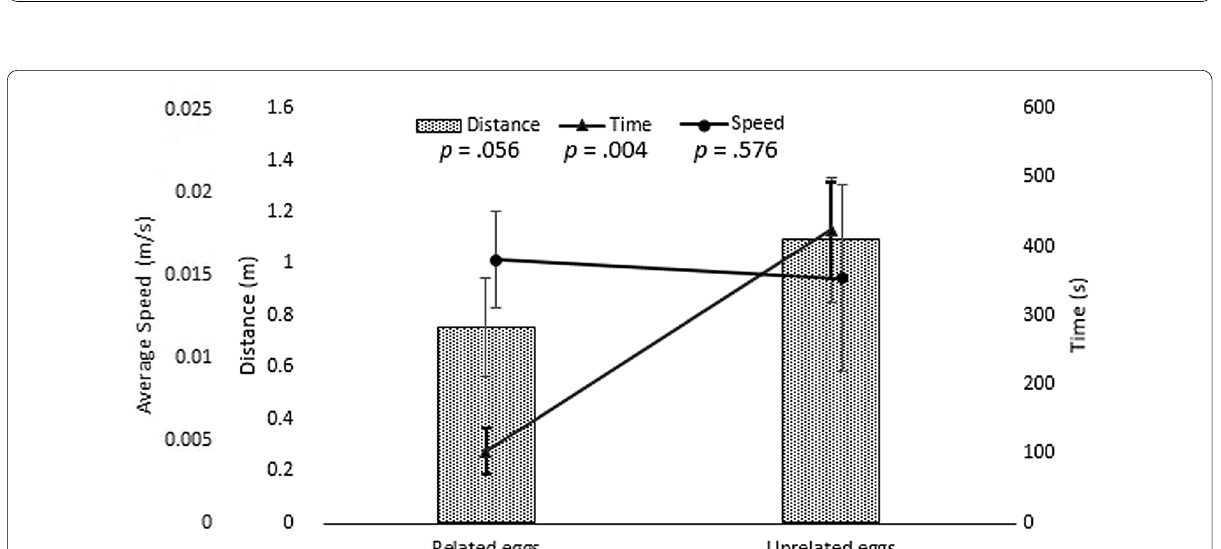
Fig. 9 Graph presents distance traveled (vertical bars), time (line with triangle ends) and speed (line with circular ends) of 2nd instar larvae of C. carnea in movement area for ten minutes. All vertical lines indicate